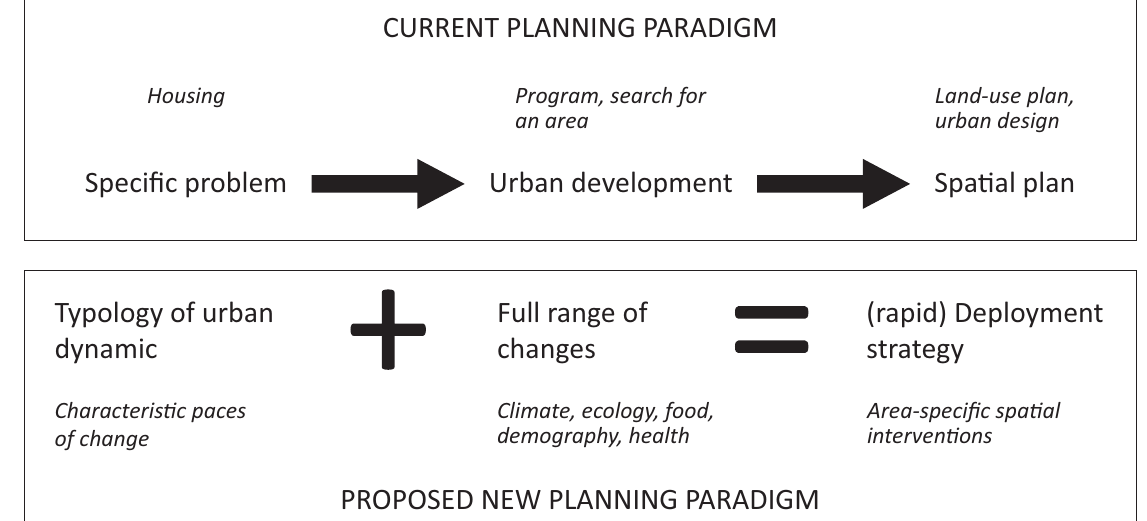
Figure 1. Proposed new planning